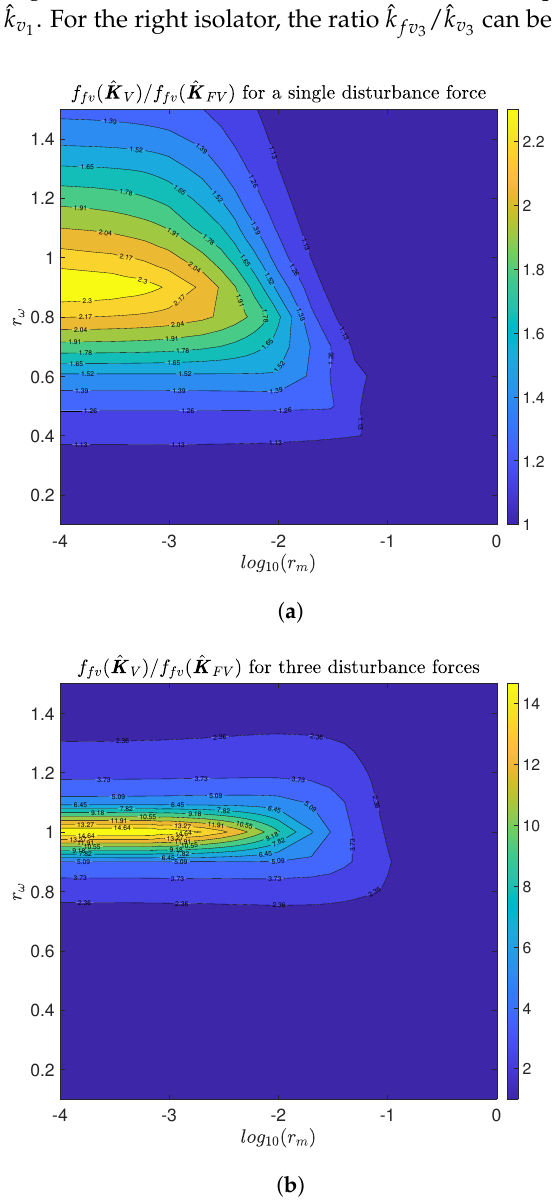
Figure 8. Ratio f fv ( ˆ K V ) / f fv ( ˆ K FV ) for: ( a ) a single disturbance force; and ( b ) three disturbance forces for the non-symmetrical